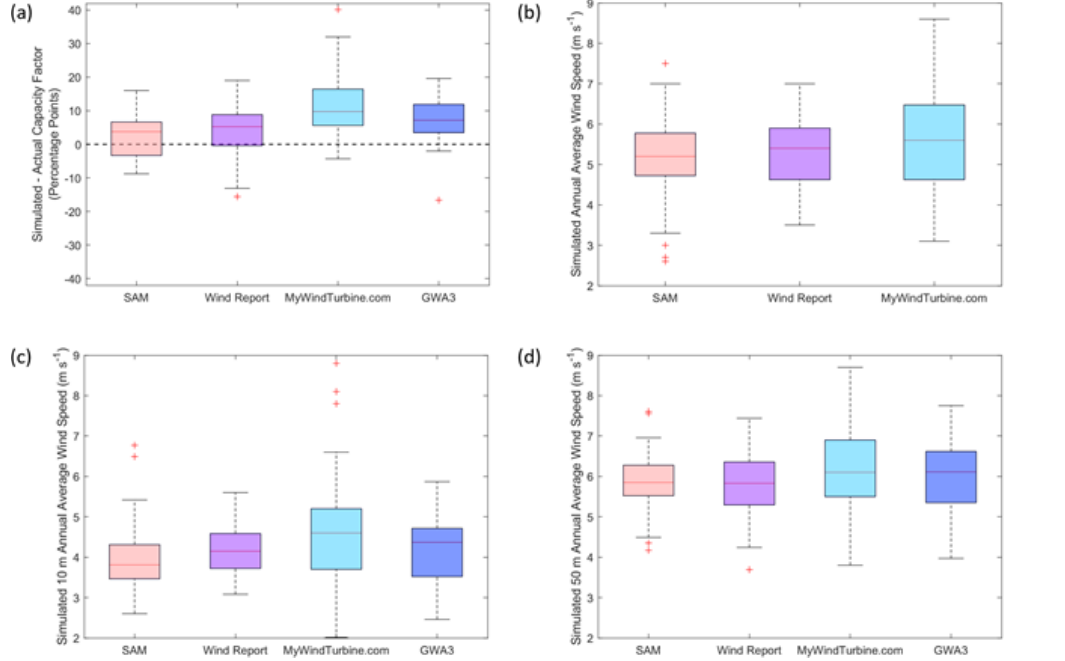
Figure 6. (a) Capacity factor error (simulated minus observed capacity factor) according to SAM, Wind Report, MyWindTurbine.com, and GWA3 across 55 small wind turbines with hub heights ranging from X to Y m. (b) Simulated annual average wind speed according to SAM, Wind Report, and MyWindTurbine.com at the 55 small wind turbine hub heights. (c) Simulated 10m annual average wind speed according to SAM, Wind Report, MyWindTurbine.com, and GWA3 at the 55 small wind turbine locations. (d) Simulated 50m annual average wind speed according to SAM, Wind Report, MyWindTurbine.com, and GWA3 at the 55 small wind turbine locations. The median values are indicated with the red lines; the 25th and 75th percentiles form the blue boxed range; the minimum and maximum error metrics, excluding outliers, are in black; and outliers are indicated with red plus